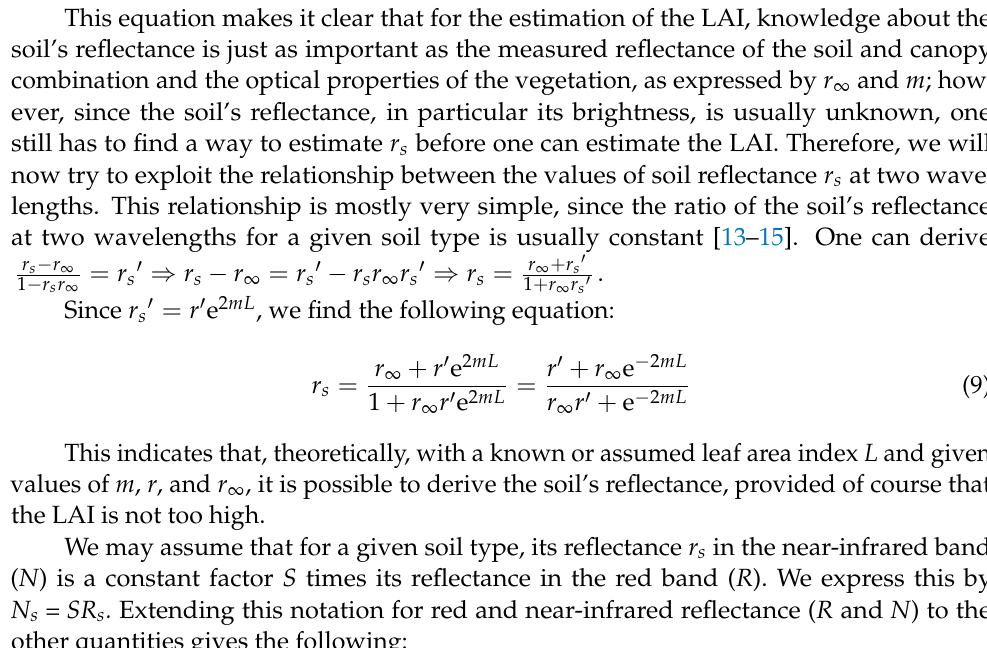
Figure 3. Same as Figure 2, but for an extended range of soil brightness. Lines of varying soil brightness values shown in red and lines of varying LAIs shown in green.